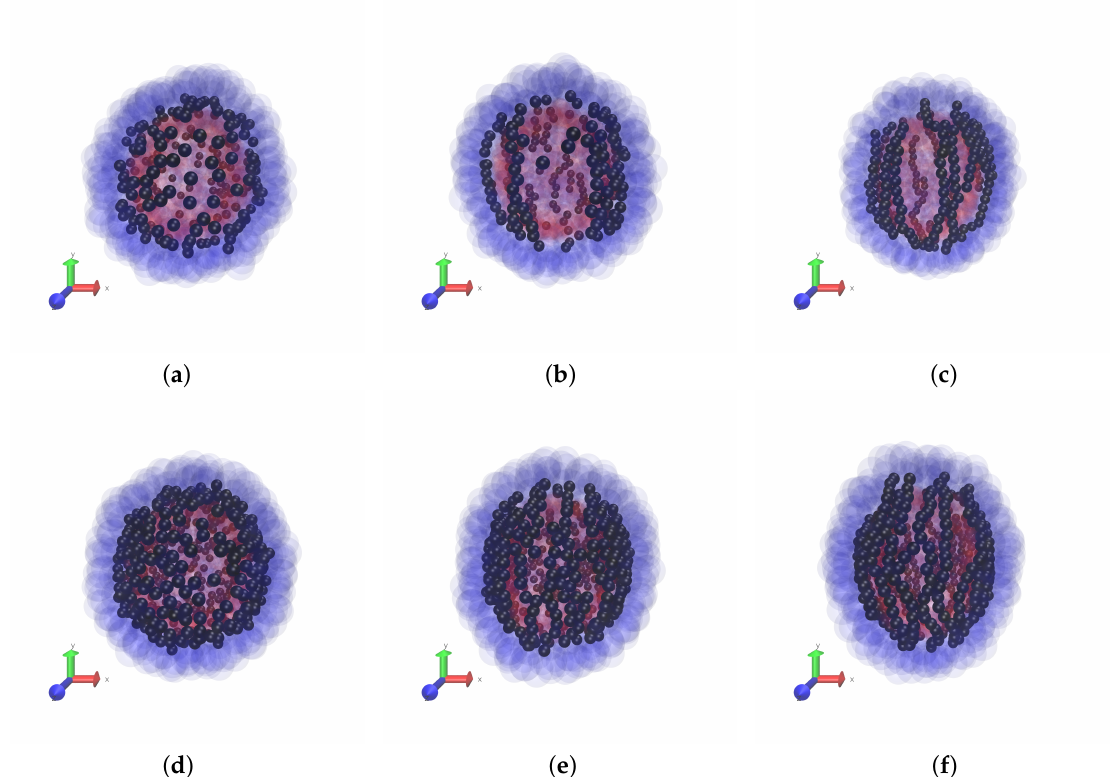
Figure 4. Under field ξ = 10. Snapshots of the particle distribution in the MPS membrane at different volume fractions: 5.5vol.%—panes ( a – c ) and 11vol.%—panes ( d – f ); different values of the magneto-dipole interaction parameter: λ = 1—panes ( a , d ), λ = 3—panes ( b , e ), λ = 5—panes ( c , f ).